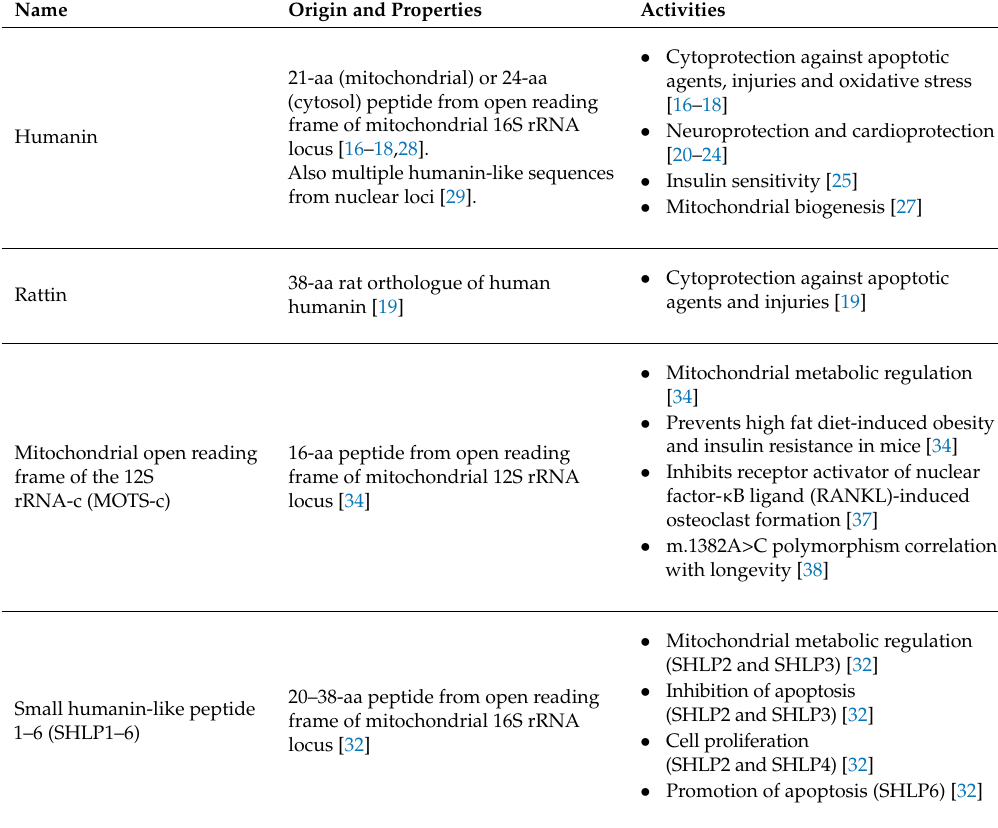
Table 1. A summary of mitochondria-derived peptides discovered to